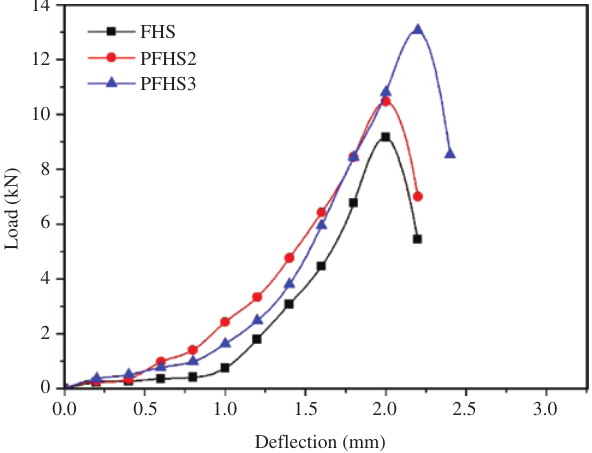
Figure 10: Load-deflection curves of the sandwich panels subjected to edgewise compression